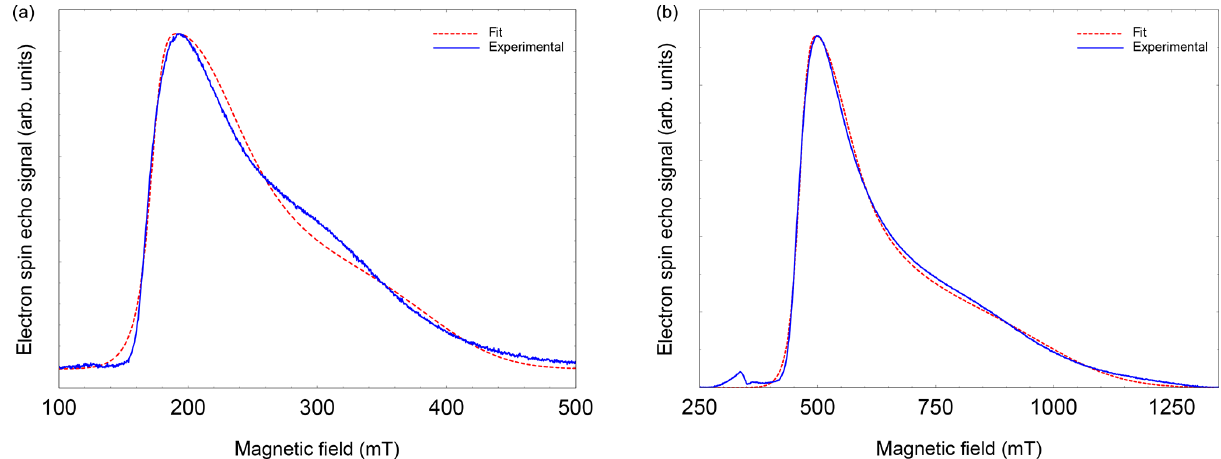
Figure 2. FSE spectra of NO@C60-OH1 ( T = 5K) with best fits. (a) S-band (3.5GHz, 10mM/CS 2 ). (b) X-band (9.7GHz, 2.5mM/CS 2 ). For fitting a set of nitrogen hyperfine tensor parameters was used, determined by ENDOR (see